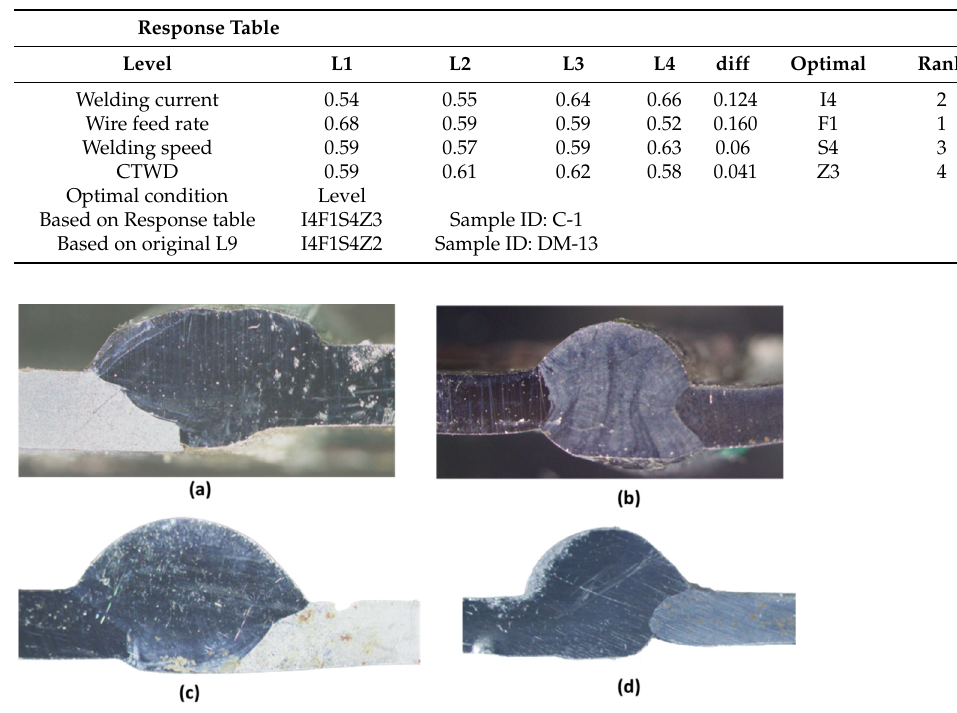
Figure 6. Macroscopic images of the weld bead: ( a ) sample DM7; ( b ) sample C1; ( c ) sample DM2 ( d ) sample DM9. ( d ) sample